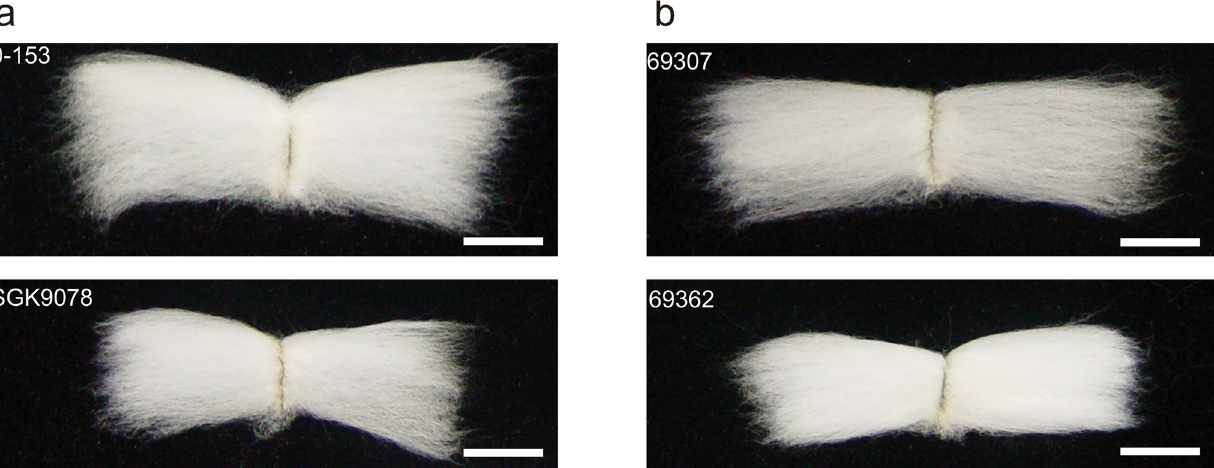
Fig 1. Phenotypic differences of fibers among the parents and the typical lines in the RIL population. a: Phenotypes of fibers of 0 – 153 and sGK9708; b: Phenotypes of fibers of two typical lines (69307 and 69362). The scale bar indicates 1